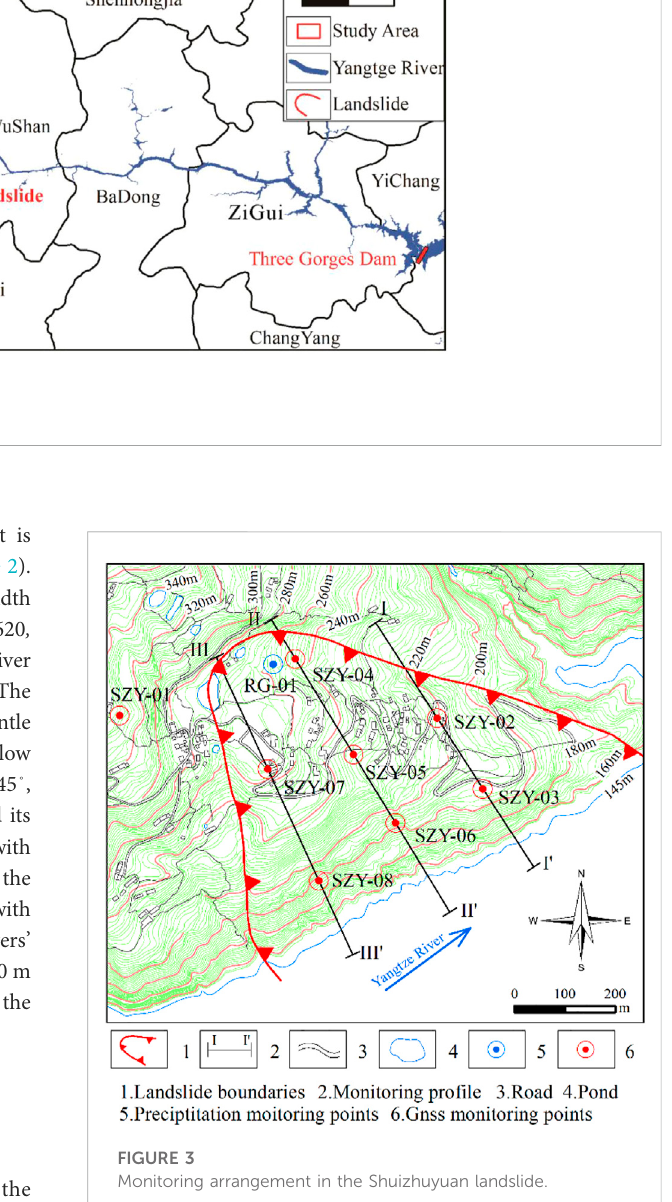
FIGURE 3 Monitoring arrangement in the Shuizhuyuan